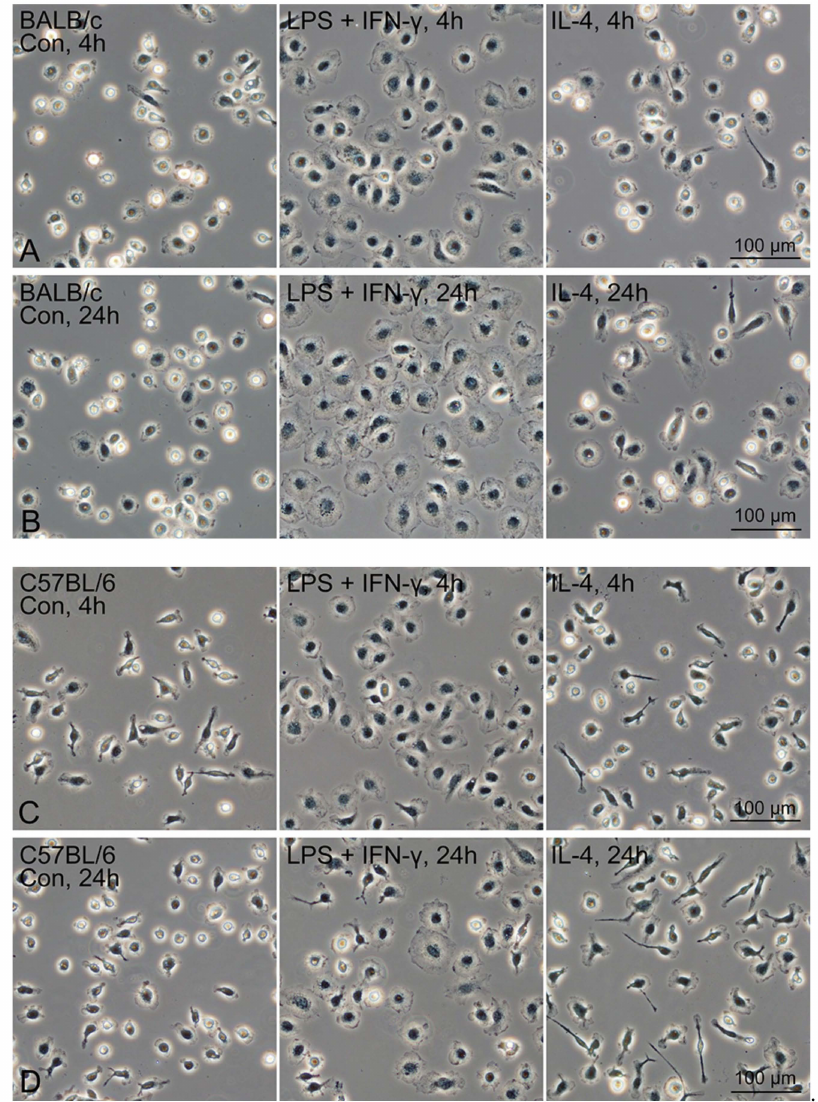
Figure 6. The morphology of propagated lung Mø treated with M1 (LPS plus IFN- γ ) and M2 (IL-4) polarisation inducer for 4 h and 24 h. Representative phase-contrast images of BALB/c ( A , B ) and C57BL/6 ( C , D ) lung Mø treated with or without (Con) the inducers for 4 h ( A , C ) and 24 h ( B , D ). Flattened and round cells extending their cytoplasm frequently appeared at 4 and 24 h after the treatment with the LPS plus IFN- γ in both BALB/c and C57BL/6 mouse